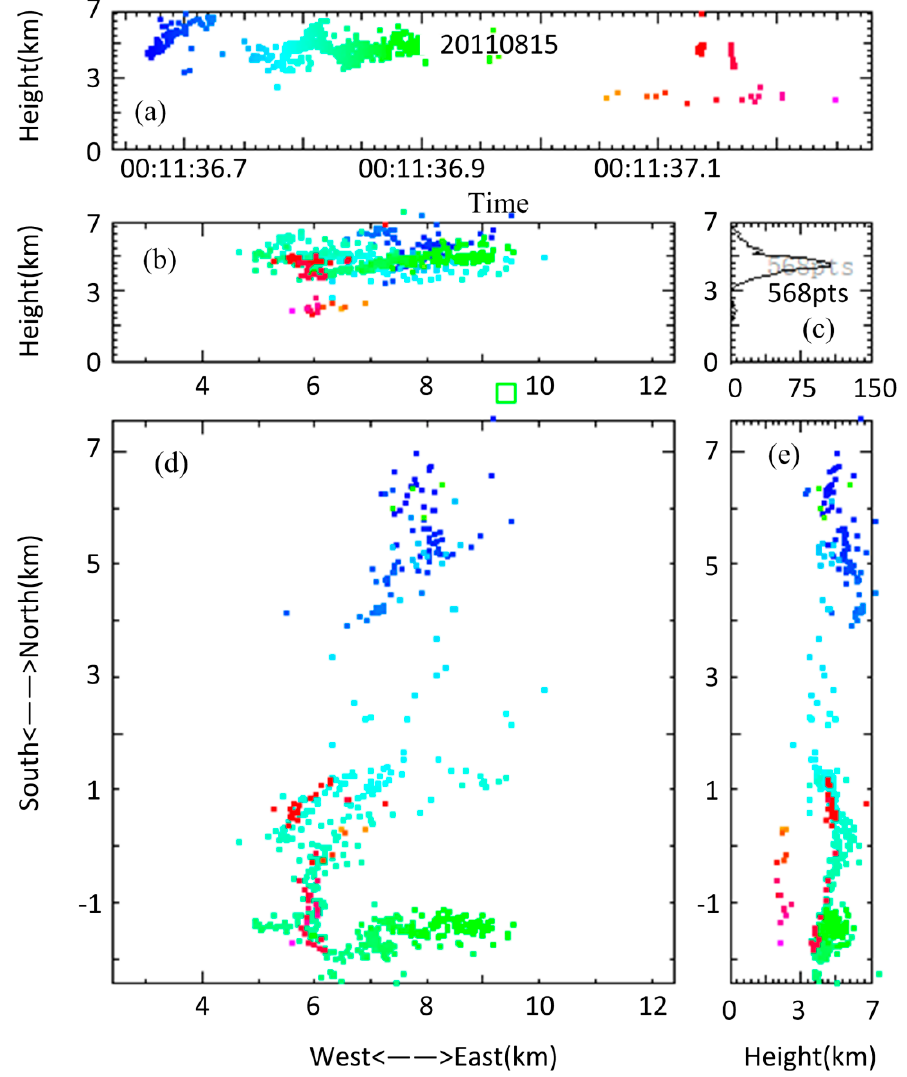
Figure 8. Location results for IC flash 001136 using the algorithm of the 3D lightning radiation source location system [20–23]. In the figure, ( a ) the height of the radiation source changes with time, ( b ) the vertical projection of the east-west direction, ( c ) the number of radiation sources changes with the height, ( d ) the horizontal projection, and ( e ) the vertical projection of the north-south direction.